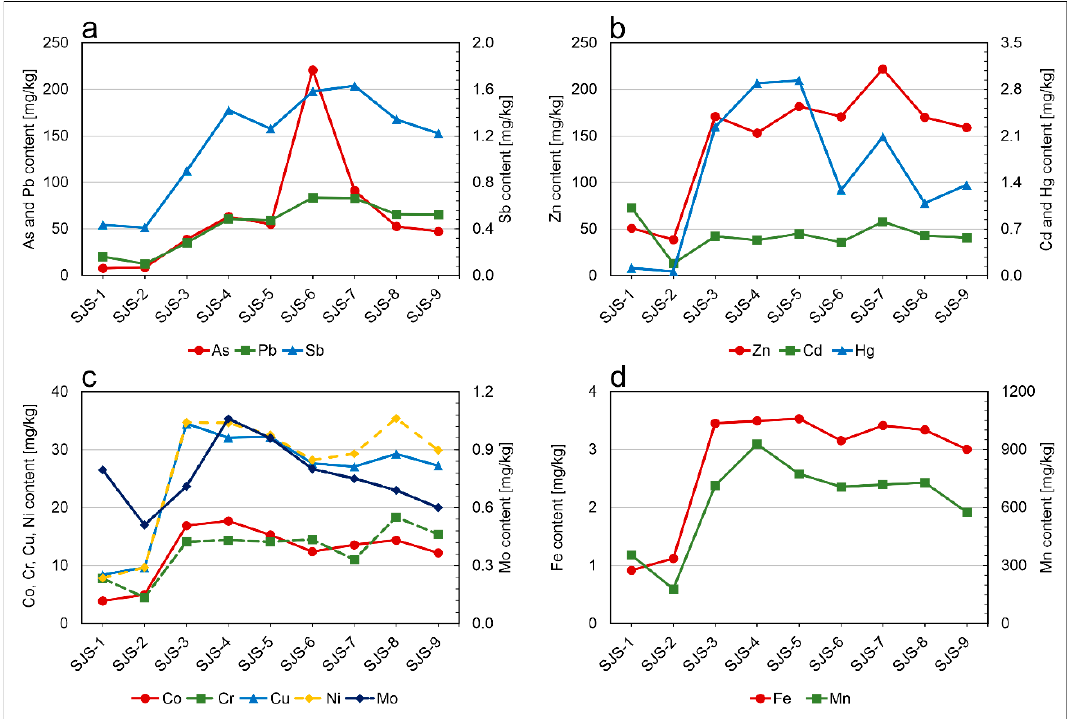
Figure 9. The distribution of PTEs according to the observed trends and correlations between PTEs: ( a ) As, Pb, and Sb; ( b ) Zn, Cd, and Hg; ( c ) Co, Cr, Cu, Ni, and Mo; and ( d ) major elements Fe and Mn.